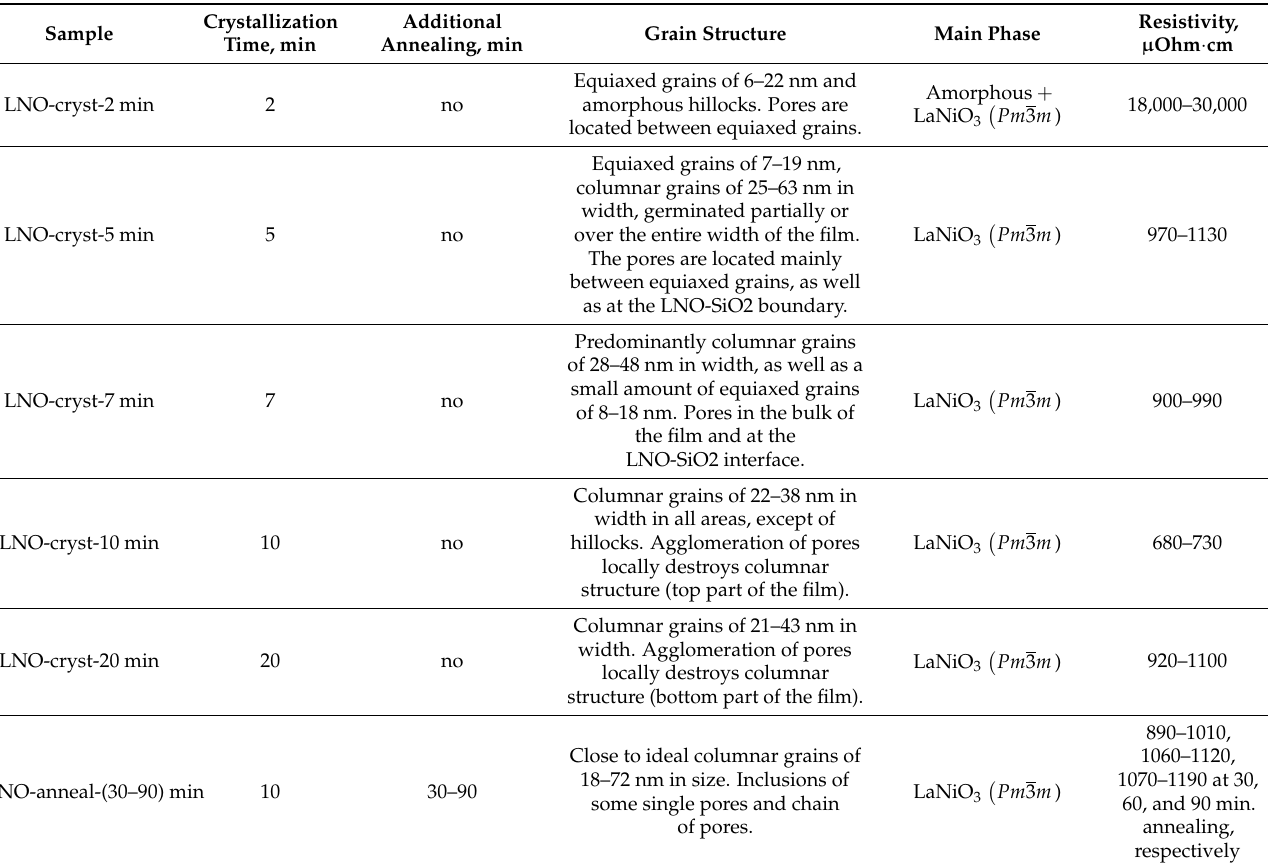
Figure 11. HAADF STEM image ( a ) and elemental map of LNO ‐ anneal ‐ 90 min sample ( b ). The sheet resistance of LNO films demonstrates some increase with the increase in annealing time duration: R s = 86.0 ± 5.0, 99.5 ± 2.3, 103.0 ± 5.9 Ohm/square at annealing 30, 60, and 90 min, respectively. Table 1 summarizes the data of the performed structural analysis. Table 1. Microstructure and sheet resistance of LNO films prepared at various annealing condi ‐ tions.